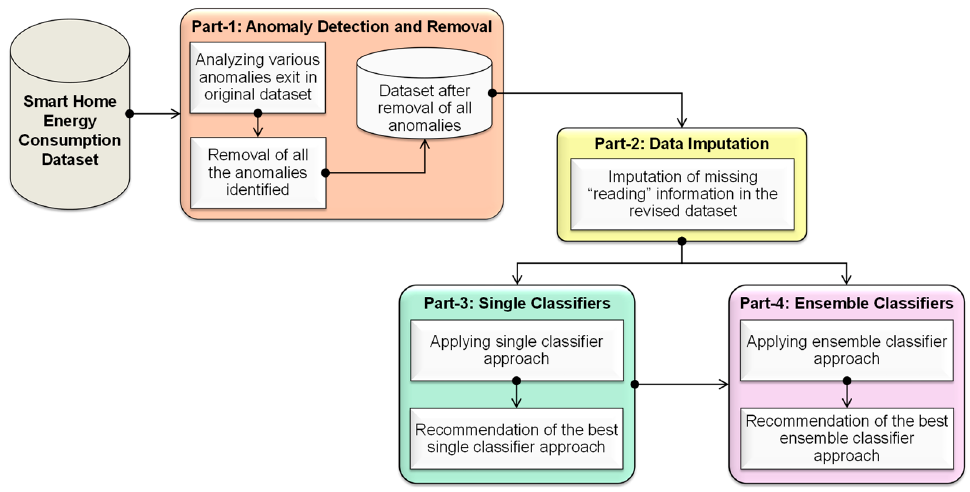
Figure 1. Conceptual model for the proposed approach.